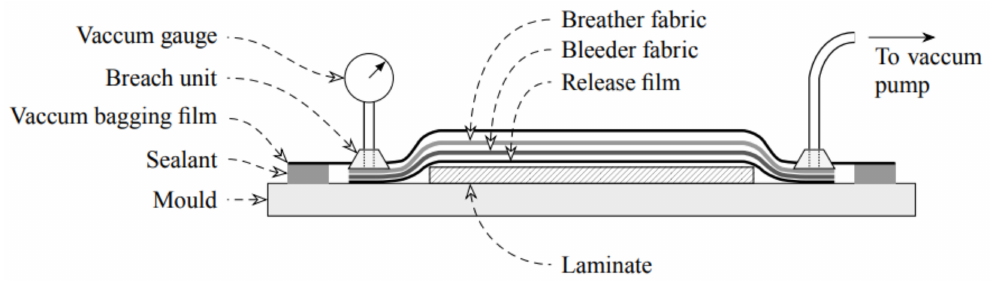
Figure 2. Vacuum Bagging Molding Process [26]. Reprinted with permission from Springer Nature.